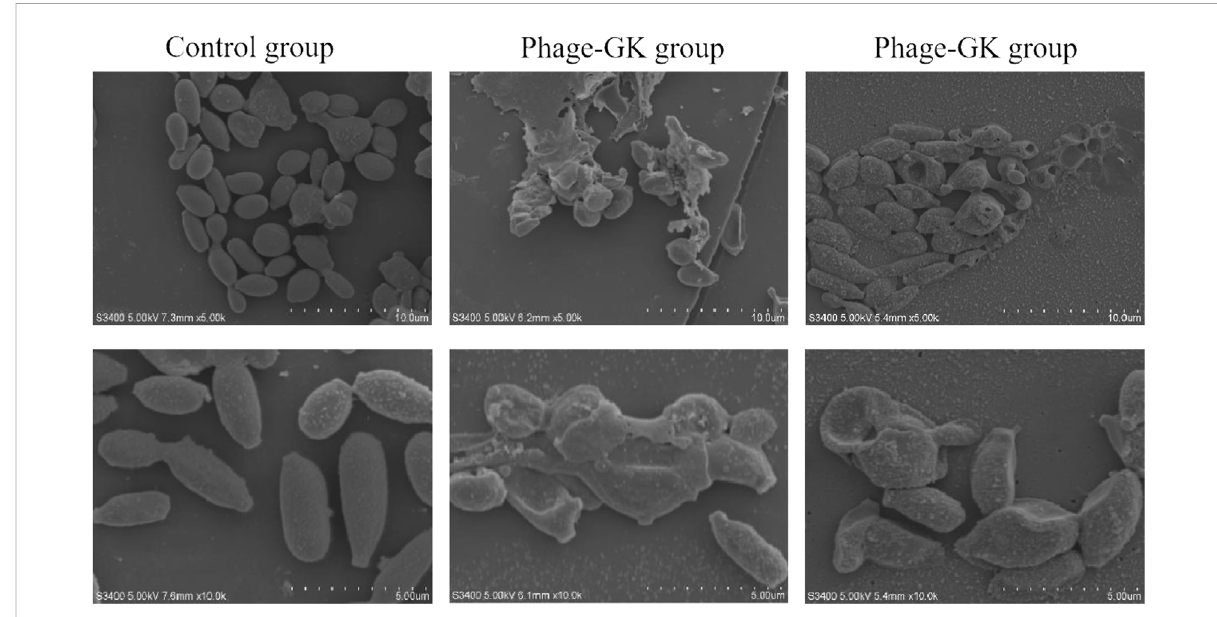
FIGURE 2 Control group under a scanning electron microscope. The normal morphology of S. globosa cells is oval-shaped and plump. Phage-GK group after PG treatment; S. globosa cells are damaged and